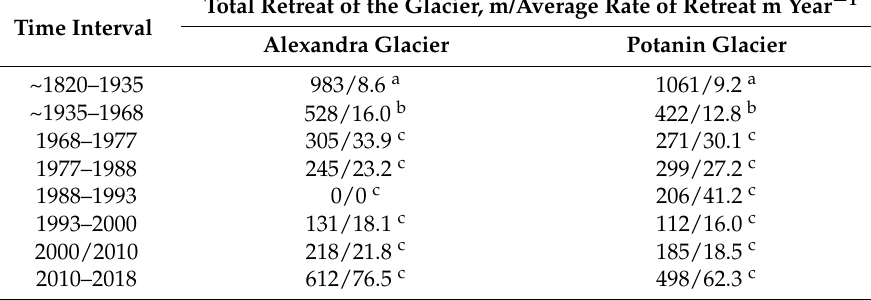
Table 7. Rates of retreat of Alexandra (No. 203) and Potanin (No. 205) glaciers. Total Retreat of the Glacier, m/Average Rate of Retreat m Year −1 Time Interval Alexandra Glacier Potanin Glacier